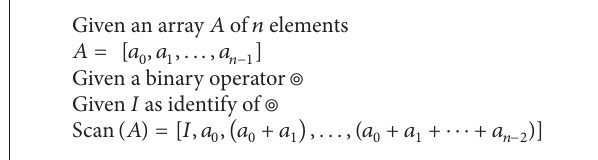
Algorithm 1: The definition of prefix-sum.